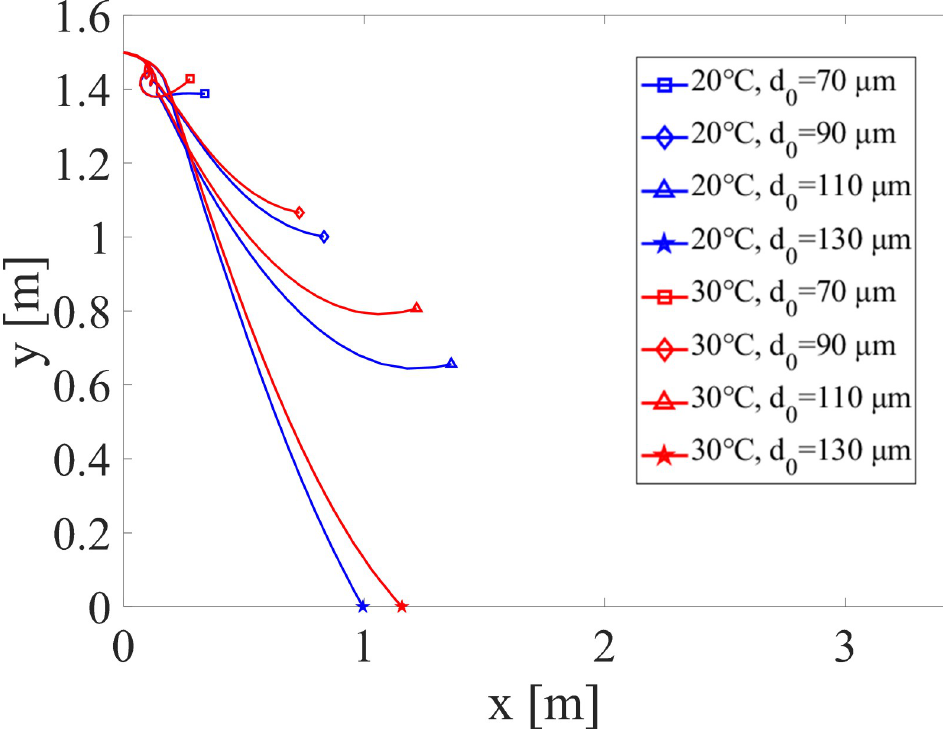
Fig 6. Droplet trajectories according to temperature at 40% relative